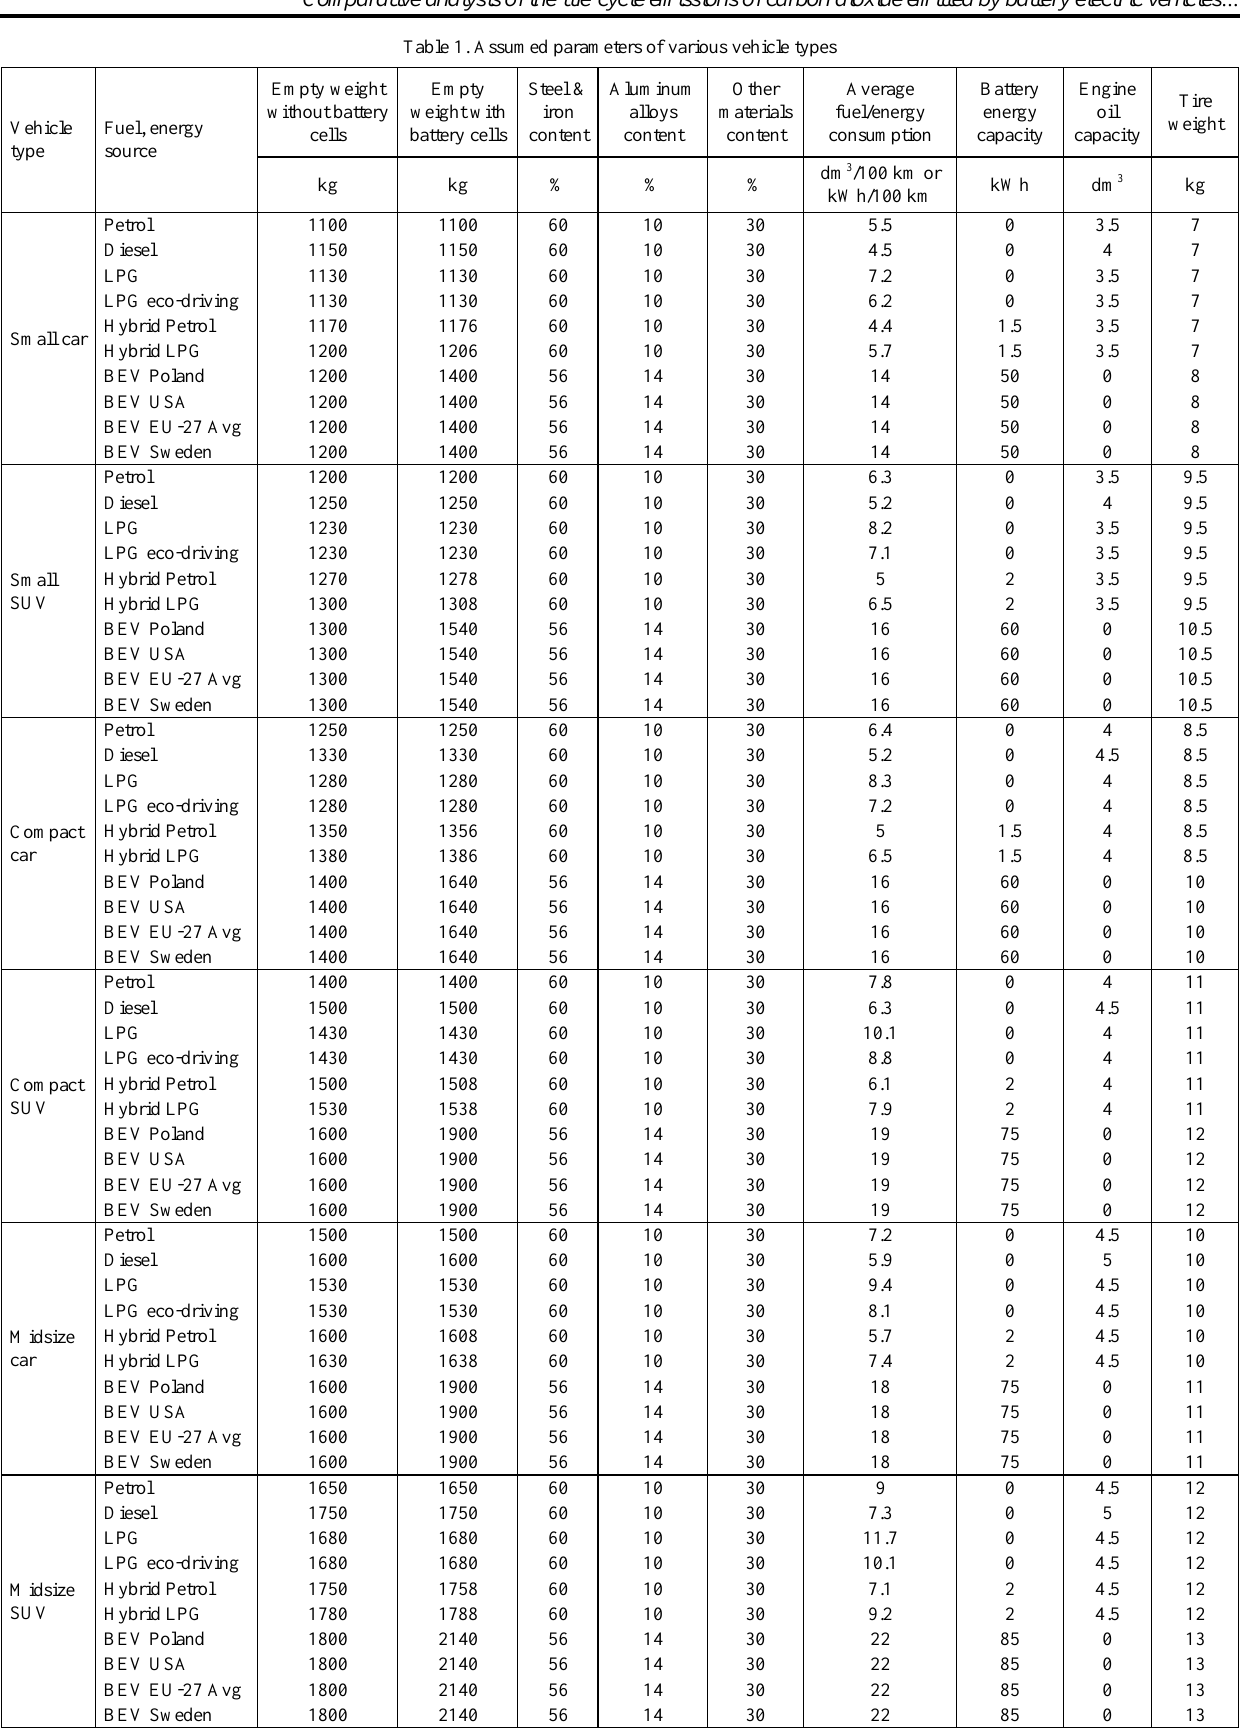
Table 1. Assumed parameters of various vehicle